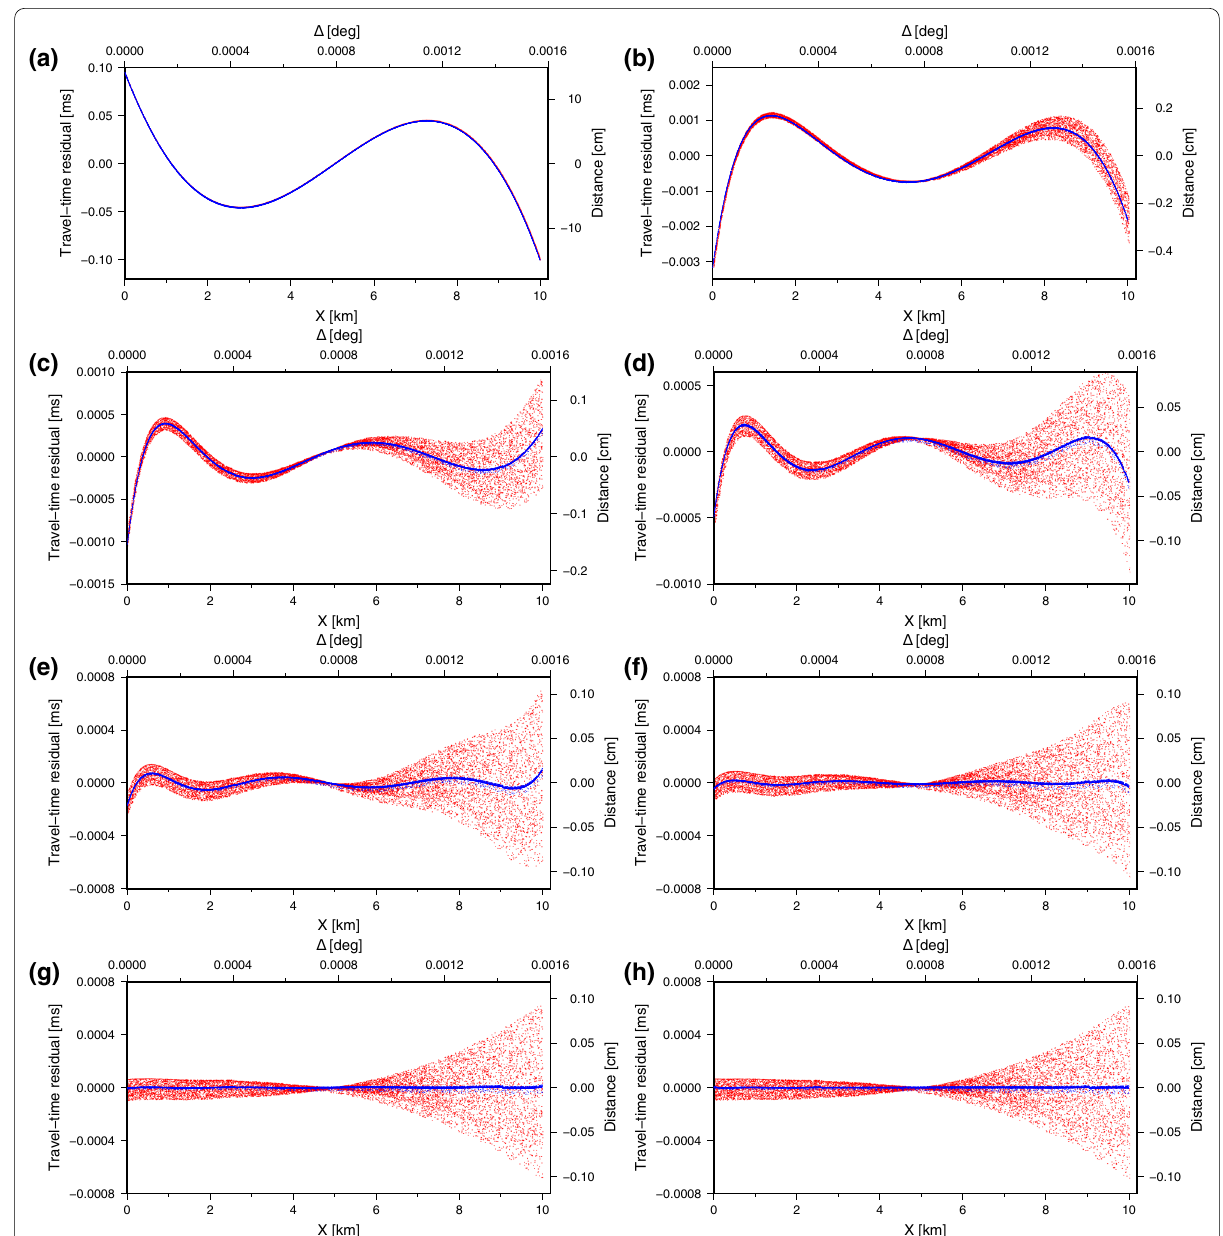
Fig. 3 Travel-time residuals for various travel-time approximation models. Red dots show travel time residuals for Model-1 (without height correction terms), and blue dots show those for Model-2 (with height correction terms). Each panel shows the travel time residuals for the two models with I th degrees of polynomial functions. a I